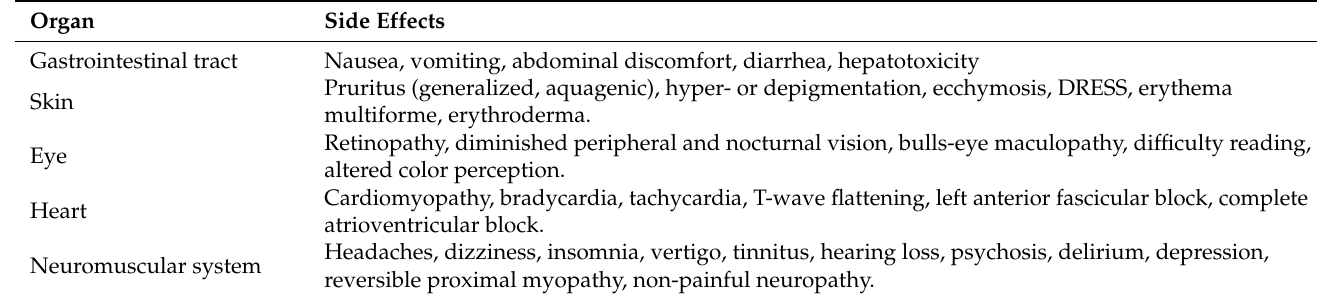
Table 2. Summary of organ-specific side effects of antimalarial